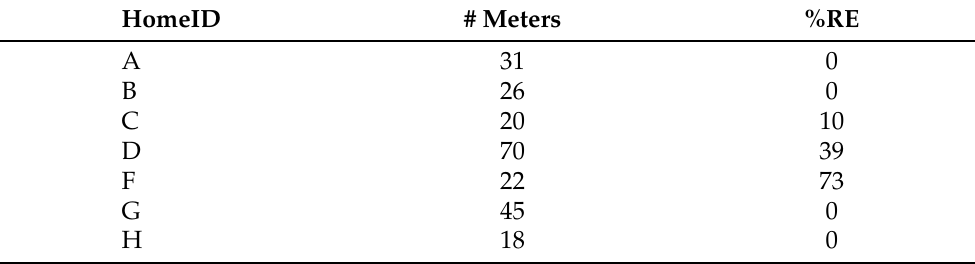
Table 1. Analysis of the